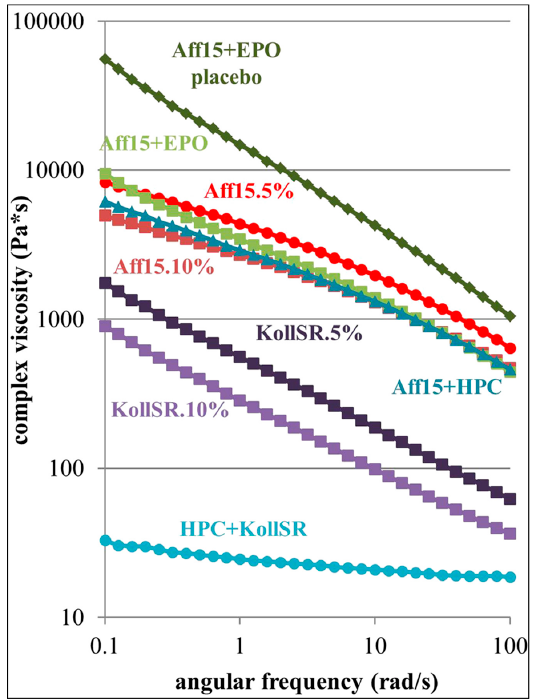
Figure 8. The rheological characterization of the blends of different polymers [Affinisol 15LV (Aff15), Kollidon SR (KollSR), Eudragit EPO (EPO), hydroxypropyl cellulose (HPC)]. Constituent effect visualized with frequency sweep at the maximum processing temperature (200 °C). Reprinted with permission from K Ilyés, European Journal of Pharmaceutical Sciences, Published by Elsevier, 2019 [136].